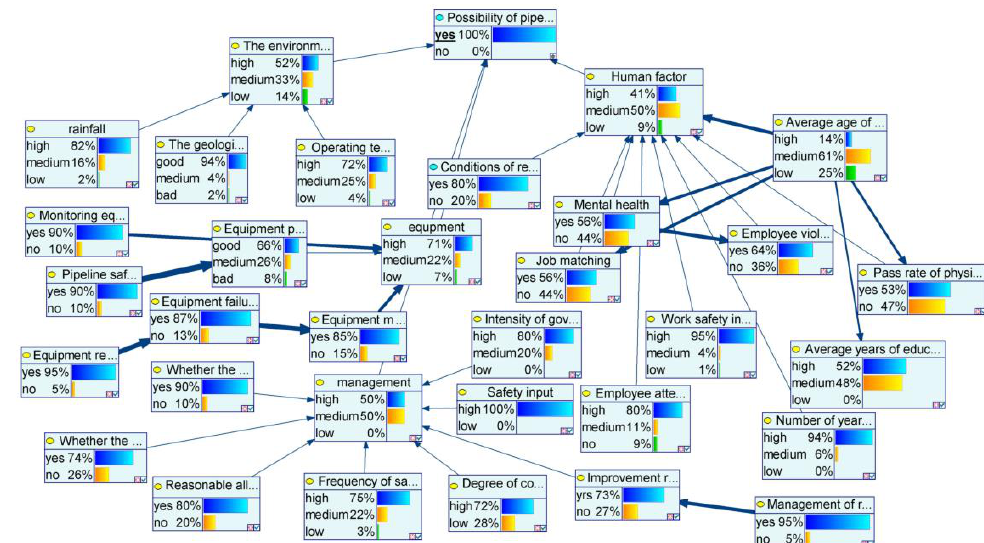
Figure 6. Analysis of the most probable cause of an